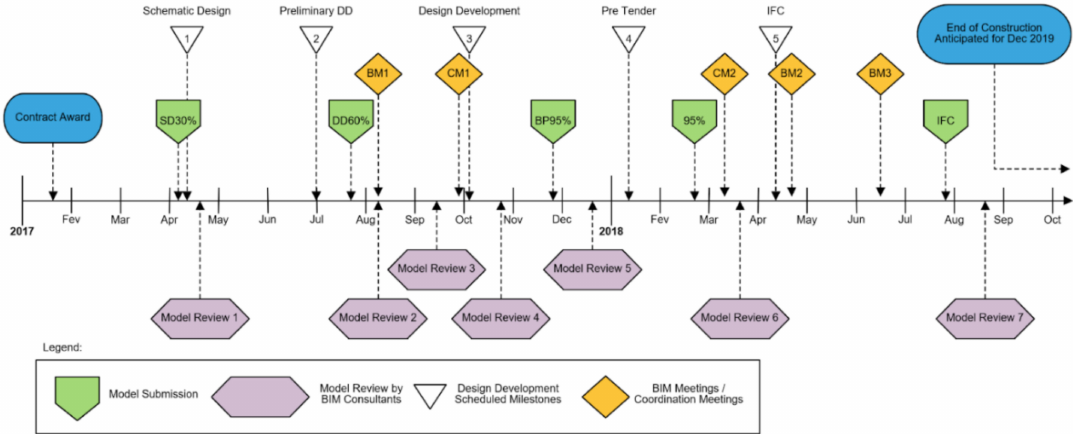
Figure 10. Timeline of the BIM compliance process during design.